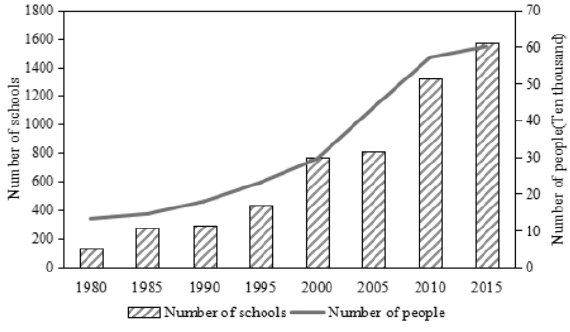
Fig. 3. Current status of research on the development of higher vocational colleges in